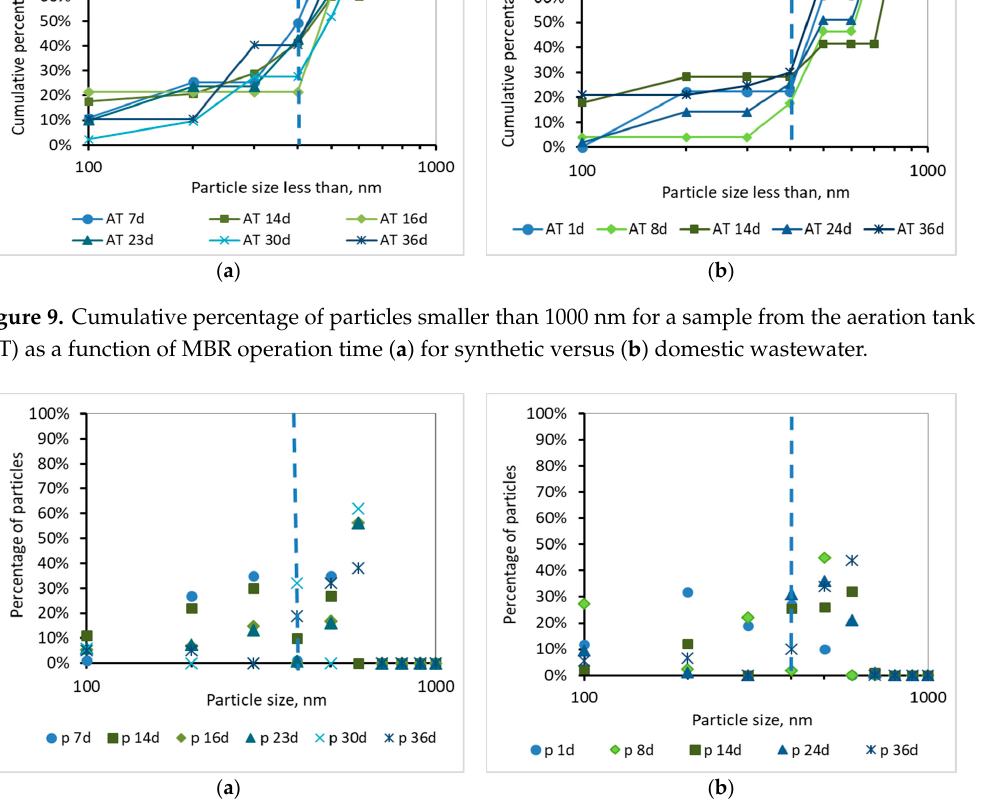
Figure 10. Percentage of particles smaller than 1000 nm for samples of the permeate (p) as a function of MBR operation time ( a ) for synthetic versus ( b ) domestic wastewater.